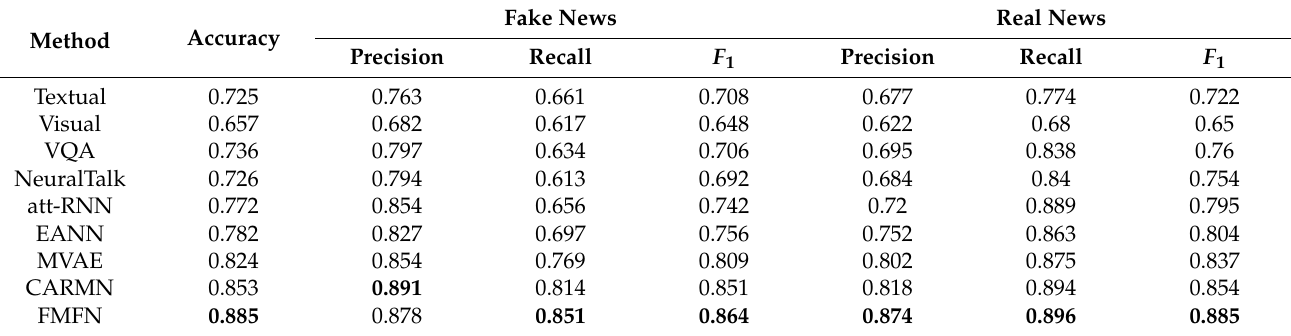
Table 2. The results of different methods on Weibo